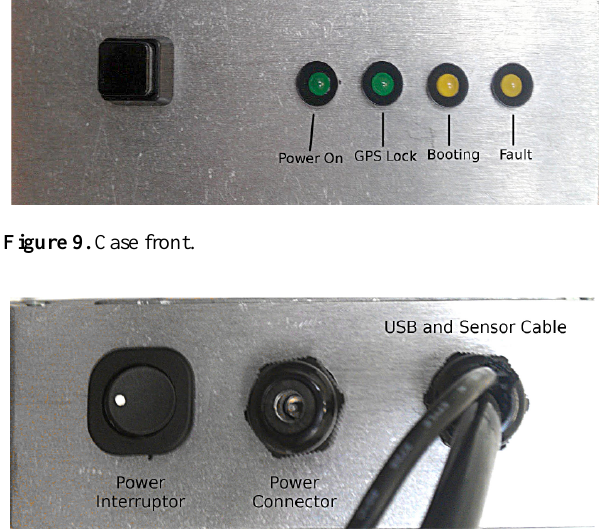
Figure 10. Case back.